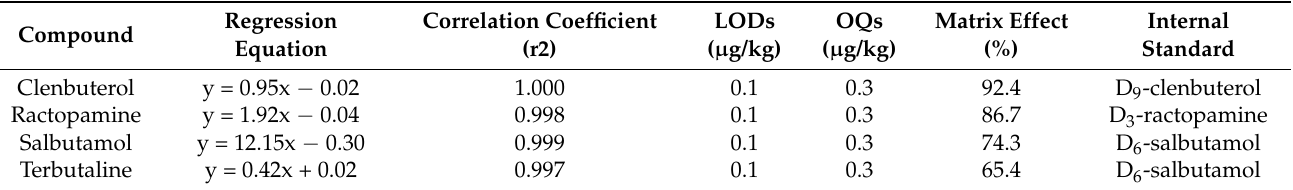
Table 3. Calibration data for the four β 2 -agonists: regression equation, correlation coefficient, LOD, LOQ, matrix effect, and internal standard used for each compound.